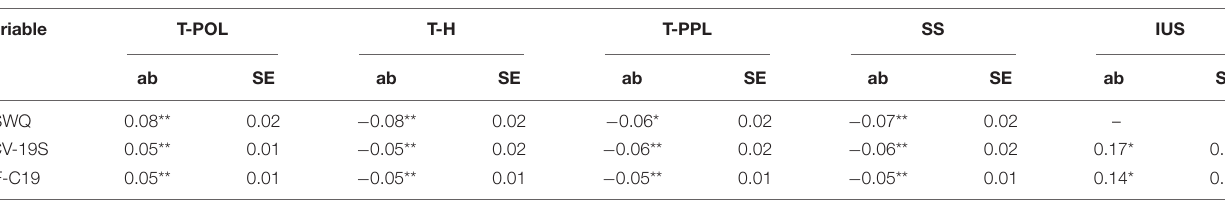
TABLE 4 | Standardized indirect effects